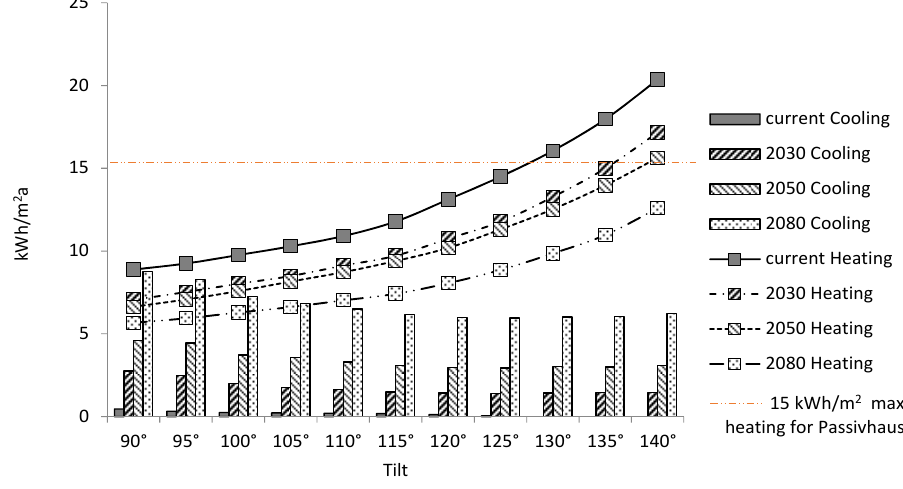
Figure 5. Annual energy demand of the pilot study unit for different façade geometries under four climate